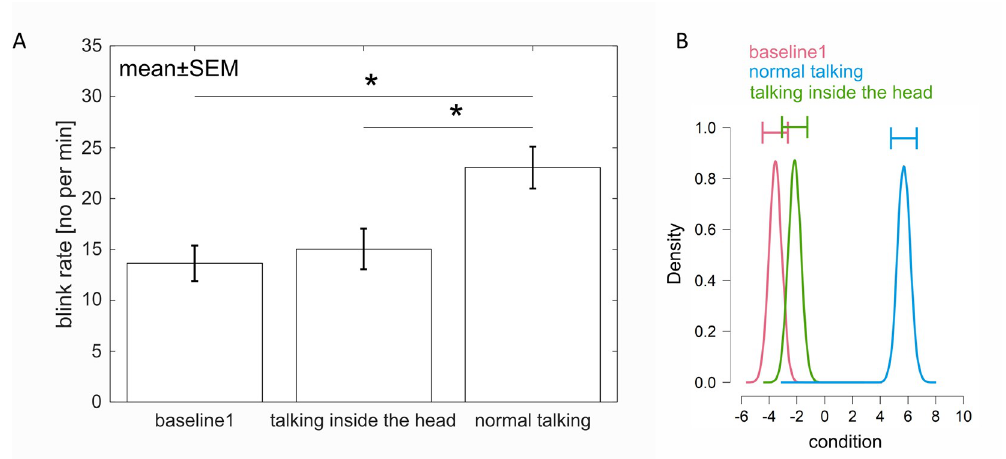
Fig 2. Influence of the cognitive component on the blink rate. A. Blink rate during “baseline1” (being at rest), “talking inside the head” and “normal talking”. Error bars represent one standard error of the mean (SEM). Stars mark significant differences revealed by parametric statistics. B. Posterior distributions of the effect of each condition on the blink rate. “Normal talking” has highest effect on blink rate followed by “talking inside the head” and “baseline1”. The horizontal error bars above each density represent 95% credible